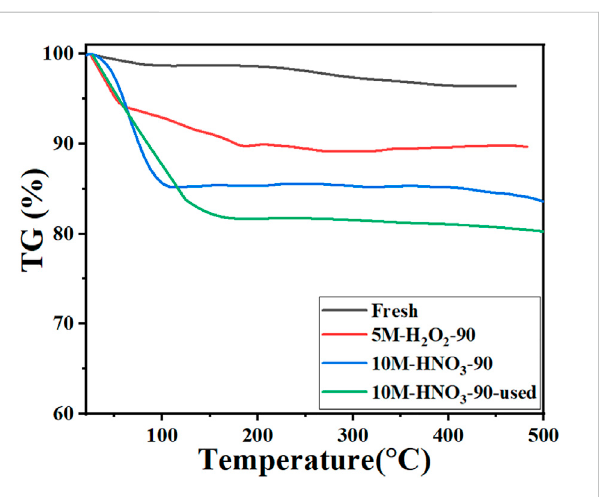
FIGURE 7 TG results of the typical activated carbon